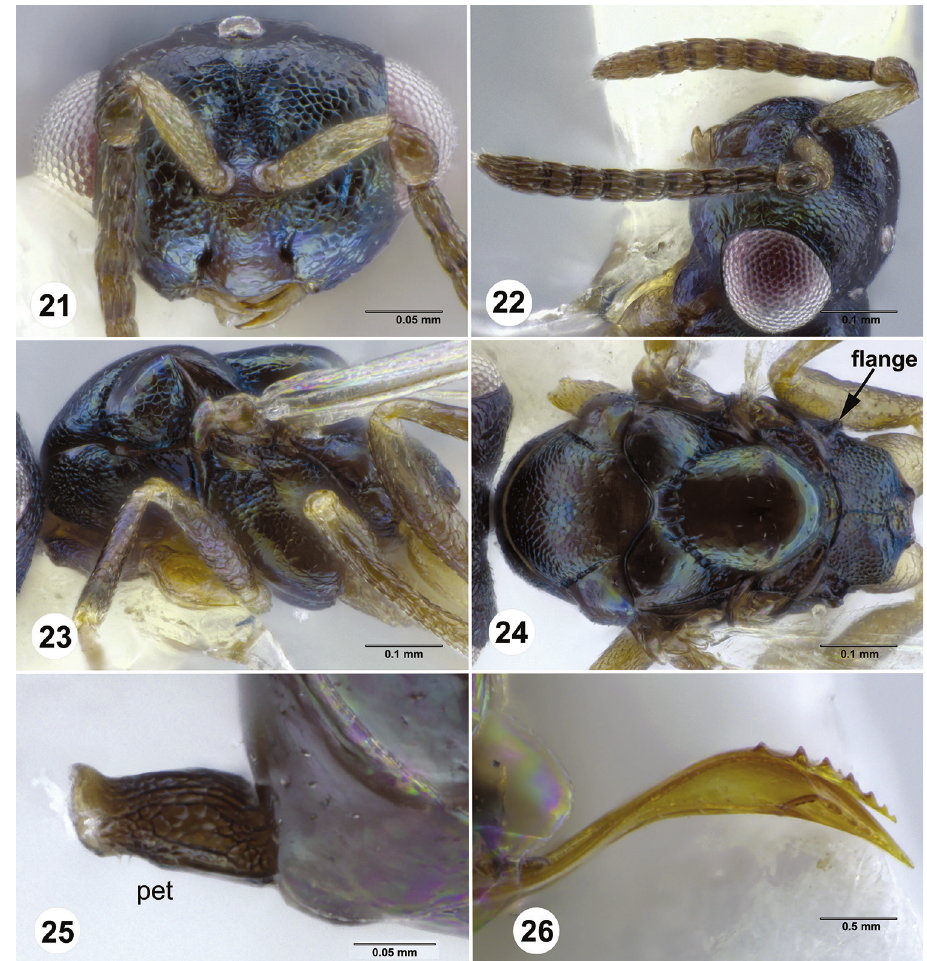
Figures 21–26. Cymosema waterworthae . Holotype female: 21 head, anterior 22 antennae, lateral 23 mesosoma, lateral 24 mesosoma, dorsal 25 petiole, lateral 26 ovipositor. pet = petiole. Female. Length 1.4 mm. Head, mesosoma, and metasoma brown with metallic luster. Scape yellowish-brown, pedicel and flagellum brown. Legs brown, with tibial apices, and first four tarsomeres pale brown. Fore wing hyaline; venation pale brown, setae dark. Gaster brown with faint metallic luster. Head (Figs 21–22) transverse, 1.6× as broad as high. Head receding ventral to to- ruli; face reticulate, including supraclypeal area; clypeus shallowly transversely rugose- reticulate, anteclypeus present; vertex not carinate. Mandibles bidentate, both teeth projecting medially, narrow and only weakly curved (Fig. 21). Palpal formula 2:1, palpi minute. Pedicel broader than F2; scape and pedicel reticulate; flagellum